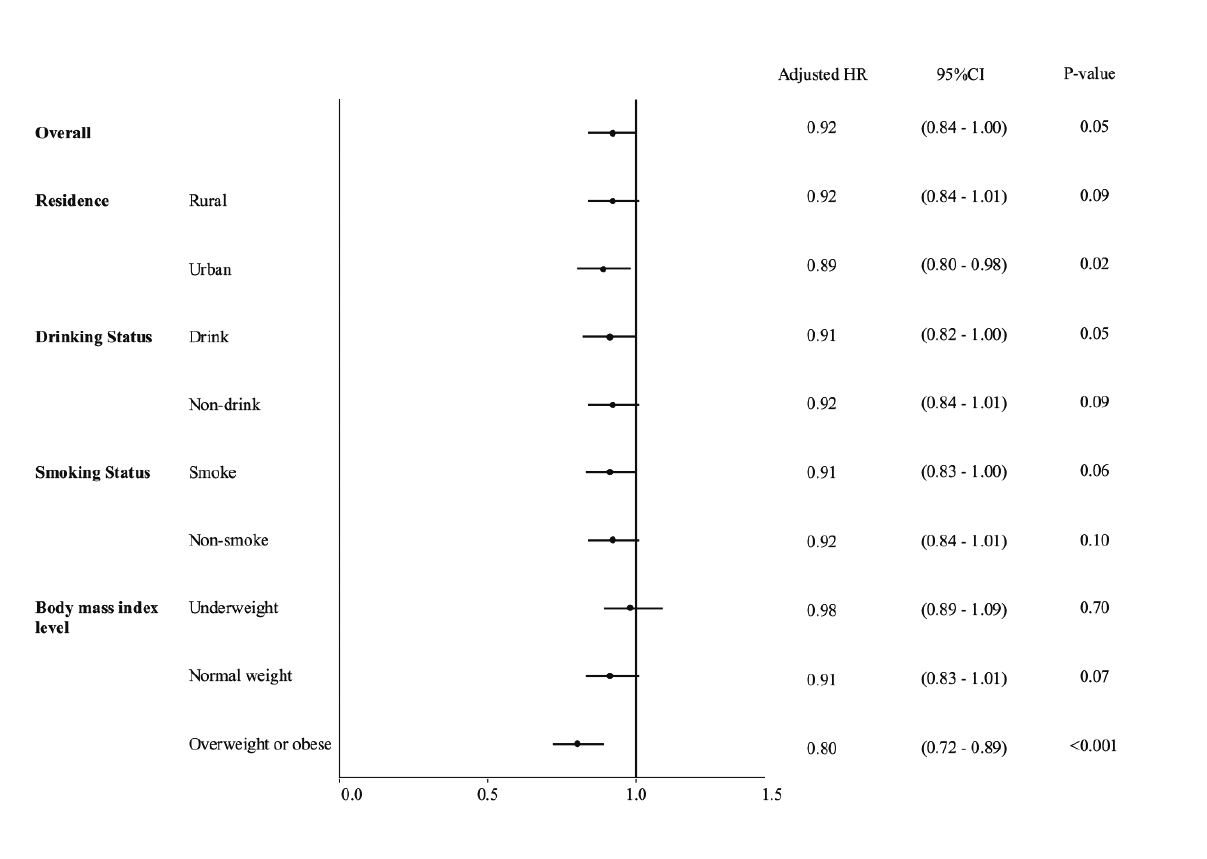
FIGURE1 Forest plot for multivariable Cox regression results to show the sex-specific association between hemoglobin and sarcopenia, stratified by residence, body mass index level, drinking status, and smoking